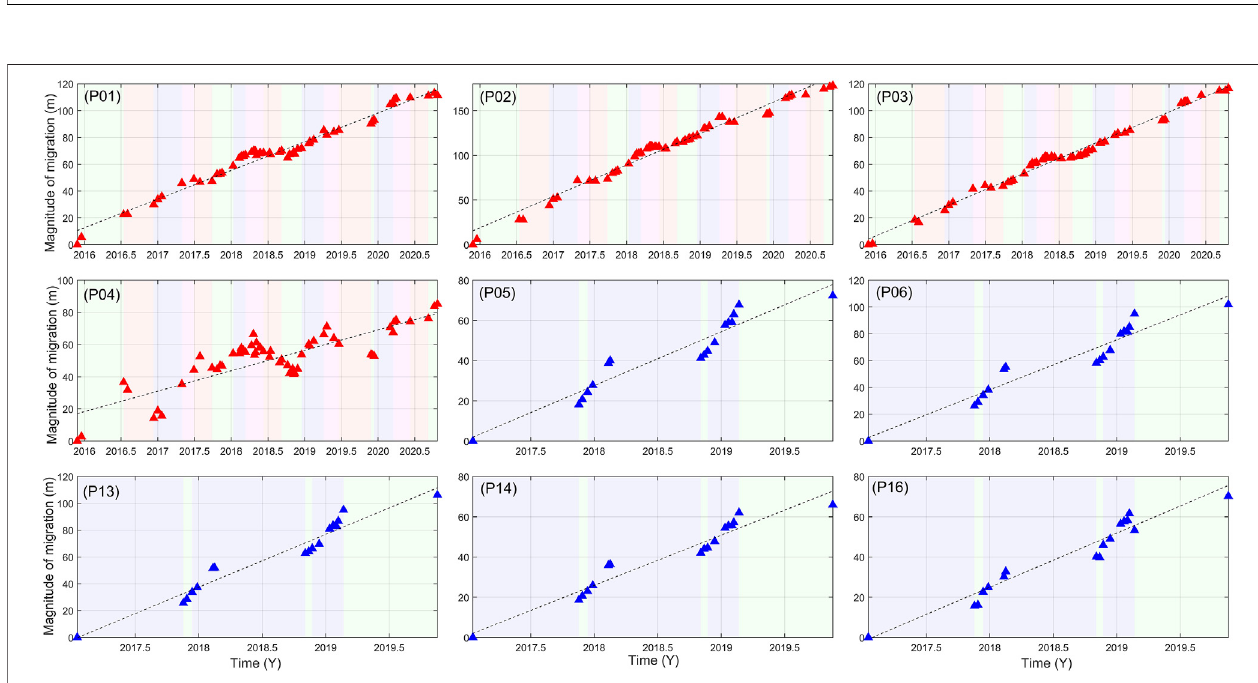
FIGURE7| Similarto Figure6 ,thetimeseriesextractedfromtheinversionoftwoSentinel-2tiles.Redandbluetrianglesdenotetheinversionofpairsbelongingto T33QYV and T33QZU, respectively.